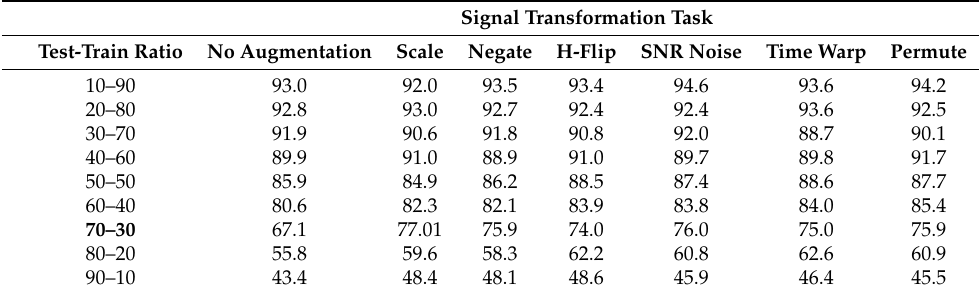
Table 2. Performance of the downstream task T d with varying test–train ratios explored for each primary augmentation separately.